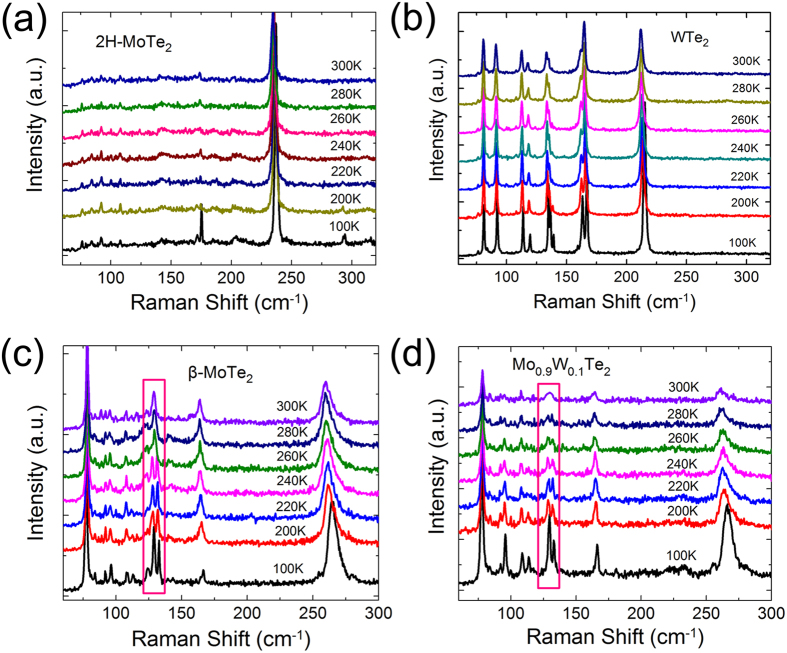
(a) Temperature-dependent Raman spectra of 2H-MoTe2 crystals. (b) Temperature-dependent Raman spectra of Td-WTe2 crystals. (c) Temperature-dependent Raman spectra of β-MoTe2 crystals. (d) Temperature dependence Raman spectra of Mo0.9W0.1Te2 (129 cm−1) and Mo0.5W0.5Te2 (130 cm−1) samples.